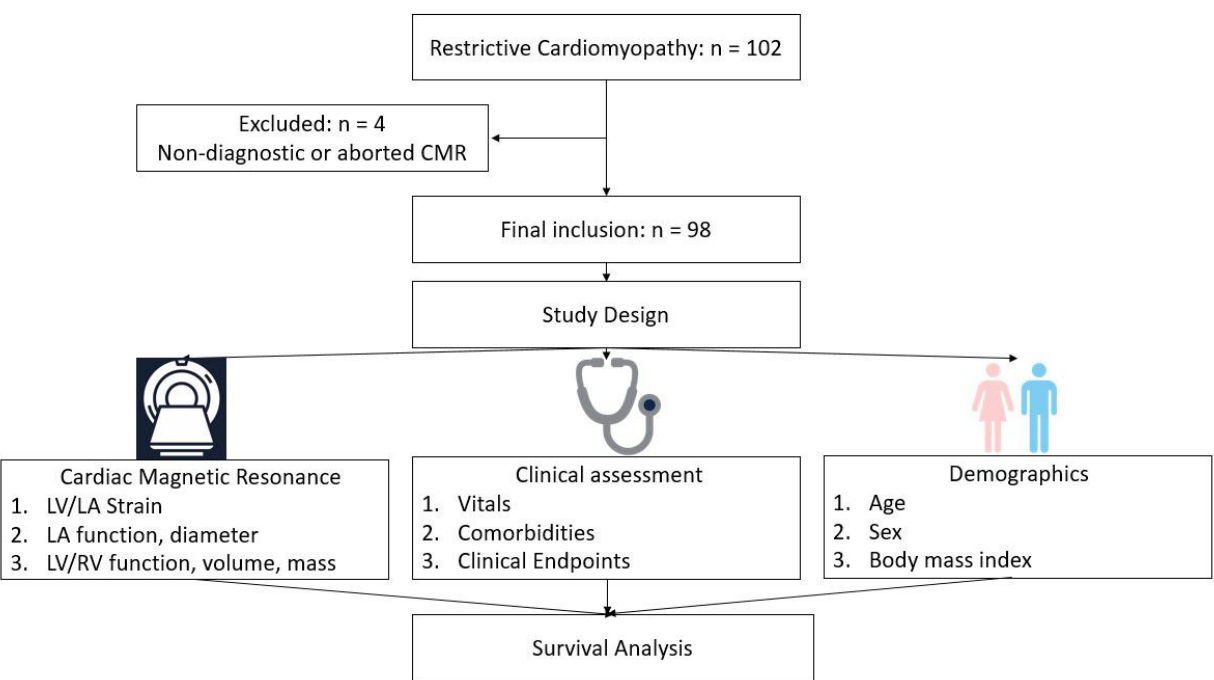
Figure 1. Flow chart of restrictive cardiomyopathy patients’ inclusion and study design. A total of 98 consecutive patients were included in the study after searching our CMR database for patients with clinical diagnosis of restrictive cardiomyopathy and excluding 4 patients with non ‐ diagnostic image quality. A qualitative and quantitative assessment of cardiac MR followed by collection of demographics and comorbidities was performed. CMR = cardiac magnetic resonance; LA = left atrium; LGE = late gadolinium enhancement; LV = left ventricle; RV = right ventricle.